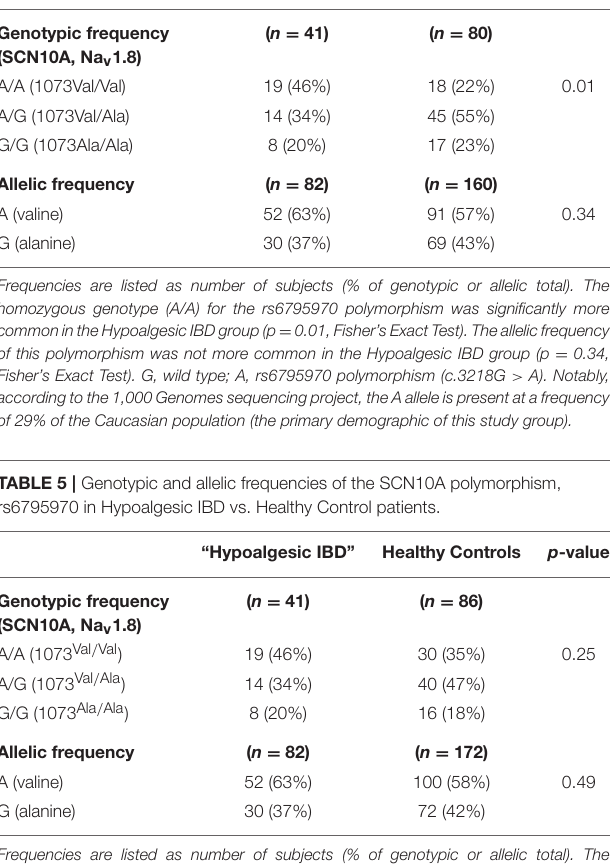
TABLE 4 | Genotypic and allelic frequencies of the SCN10A polymorphism, rs6795970 in Hypoalgesic IBD vs. “Other IBD” patients. “Hypoalgesic IBD” Other IBD p -value